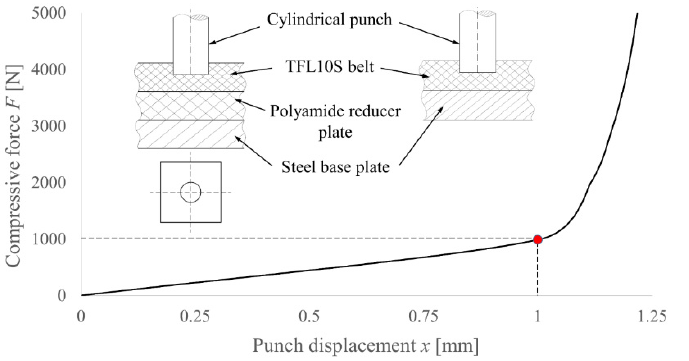
Figure 16. Behavior of the polyamide PA6 reducer plate under compressive load of the punch with diameter d = 10 mm.